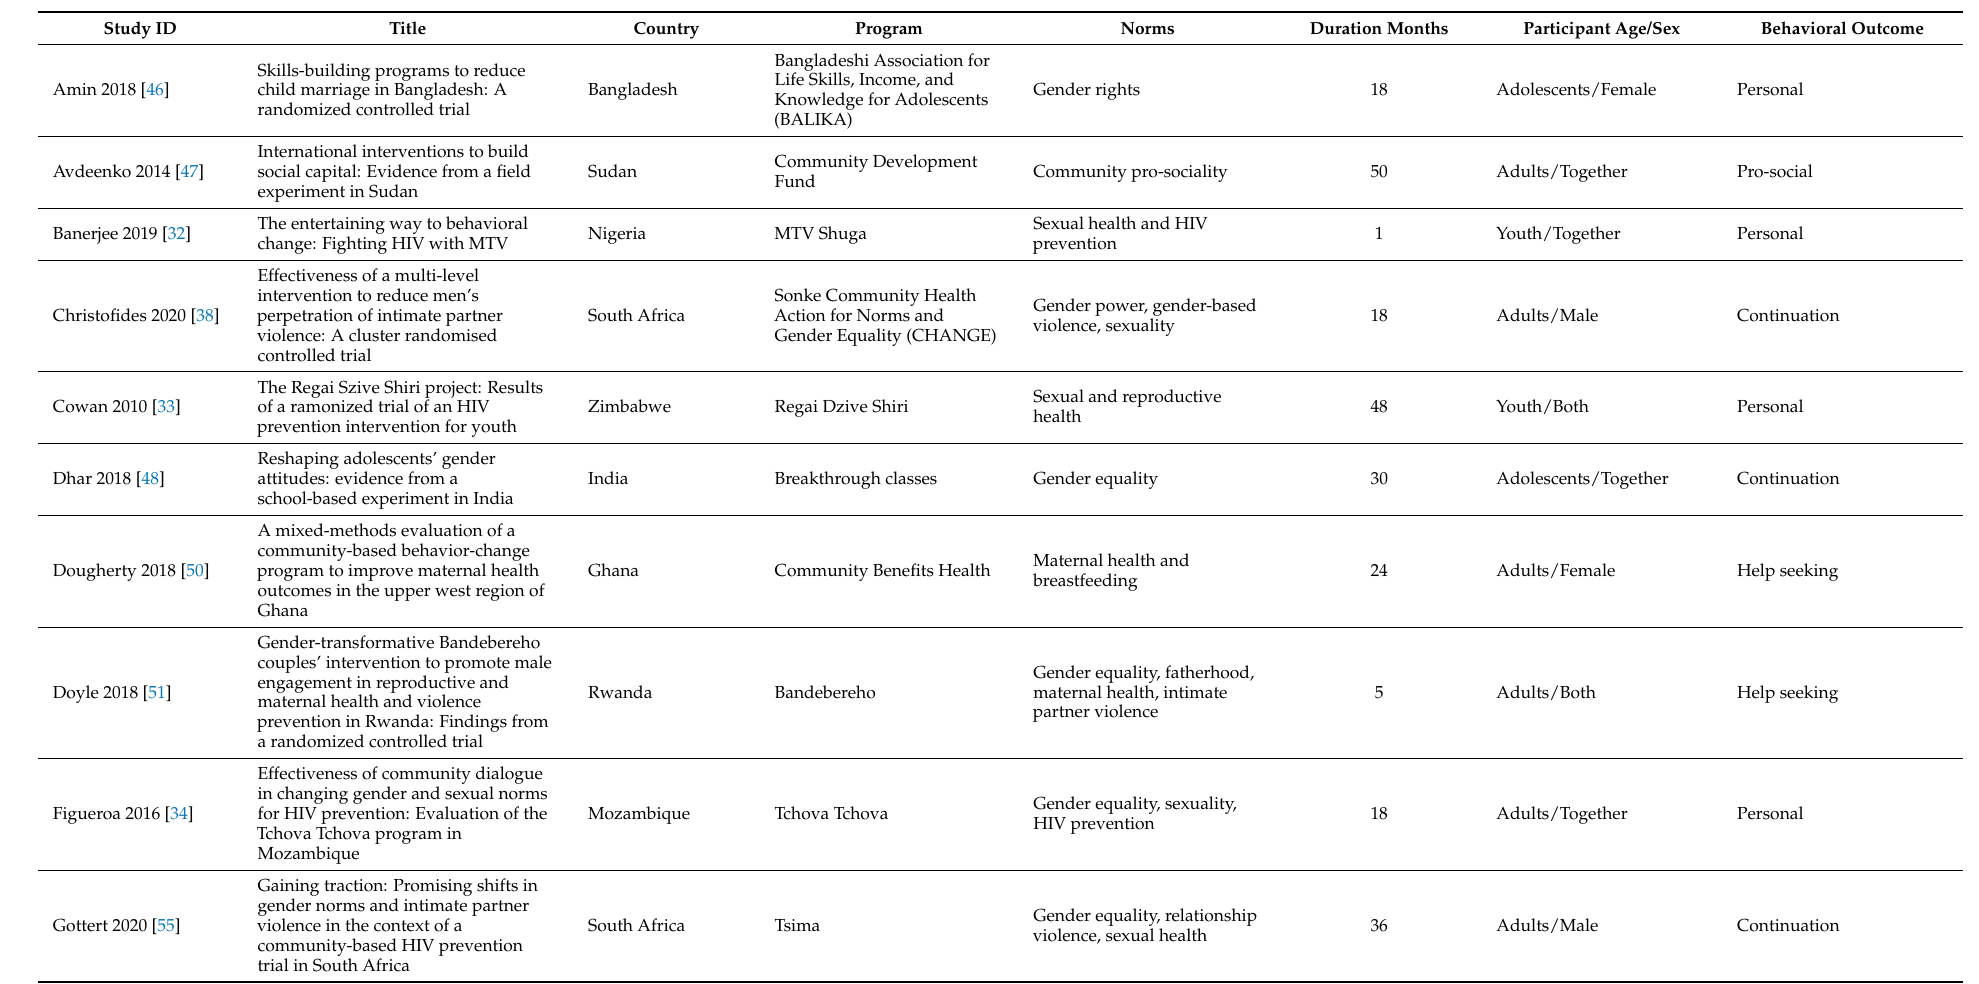
Table 1. Features of included primary